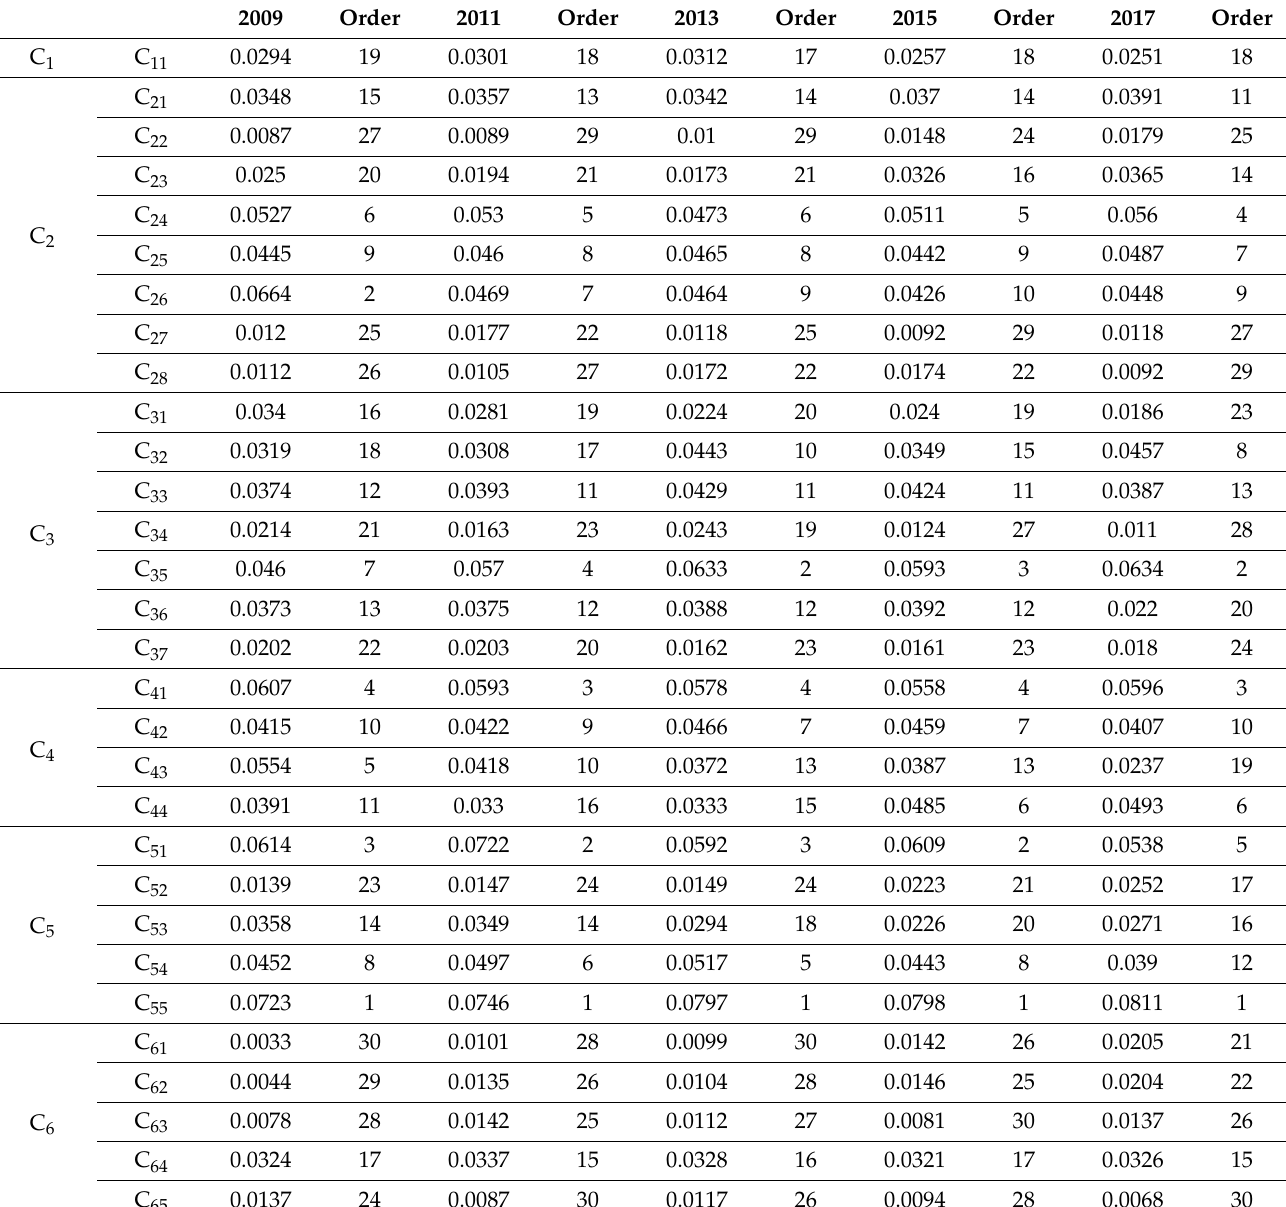
Table 2. The second-level indicators’ entropy weights from 2009 to 2017.